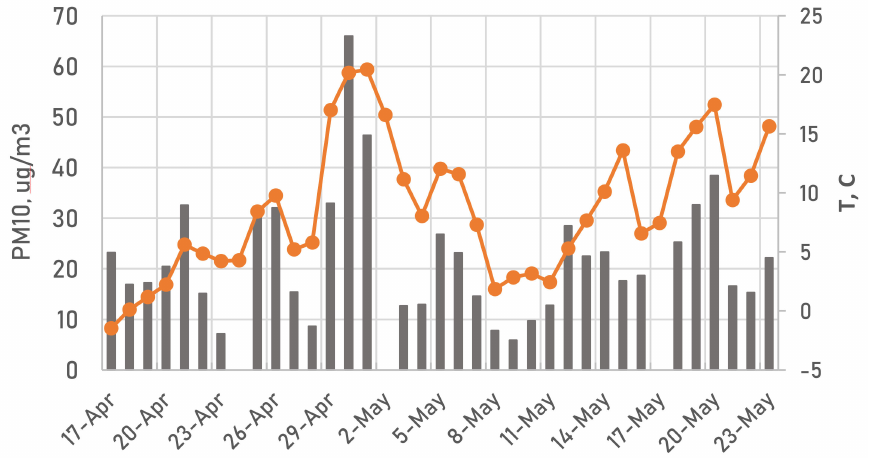
Figure 2. PM10 mass concentrations and temperature over the sampling period at MO